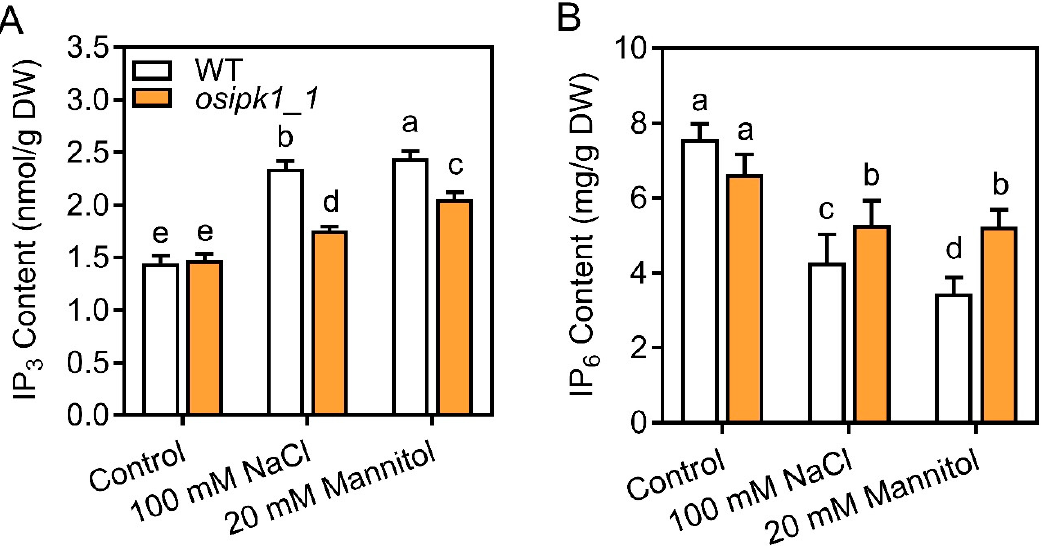
Figure 5. Accumulation of inositol triphosphate (IP 3 , A ) and phytic acid P (IP 6 , B ) in Xidao #1 (WT) and its OsIPK1 mutant line osipk1_1 . All analyses were performed with three replicates. Error bars represent standard error. The different letters (a, b, c, d, and e) show the significant difference at a probability of p ˂ 0.05.